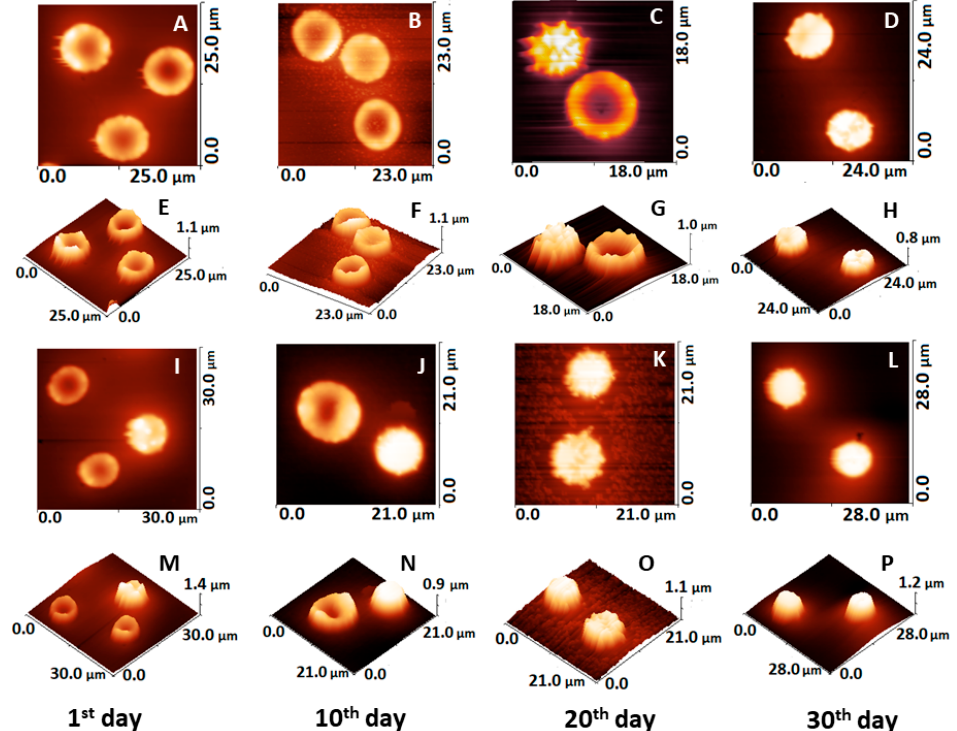
Figure 4. AFM images taken on smears of fresh and aged RBCs from healthy and PD donors on glass support, the scanned area is given on each image. 2D and 3D images of healthy cells: fresh ( A , E ), 10-day-aged ( B , F ), 20-day-aged ( C , G ) and 30-day-aged ( D , H ), and of PD cells: fresh ( I , M ), 10-day-aged ( J , N ), 20-day-aged ( K , O ) and 30-day-aged ( L , P ).